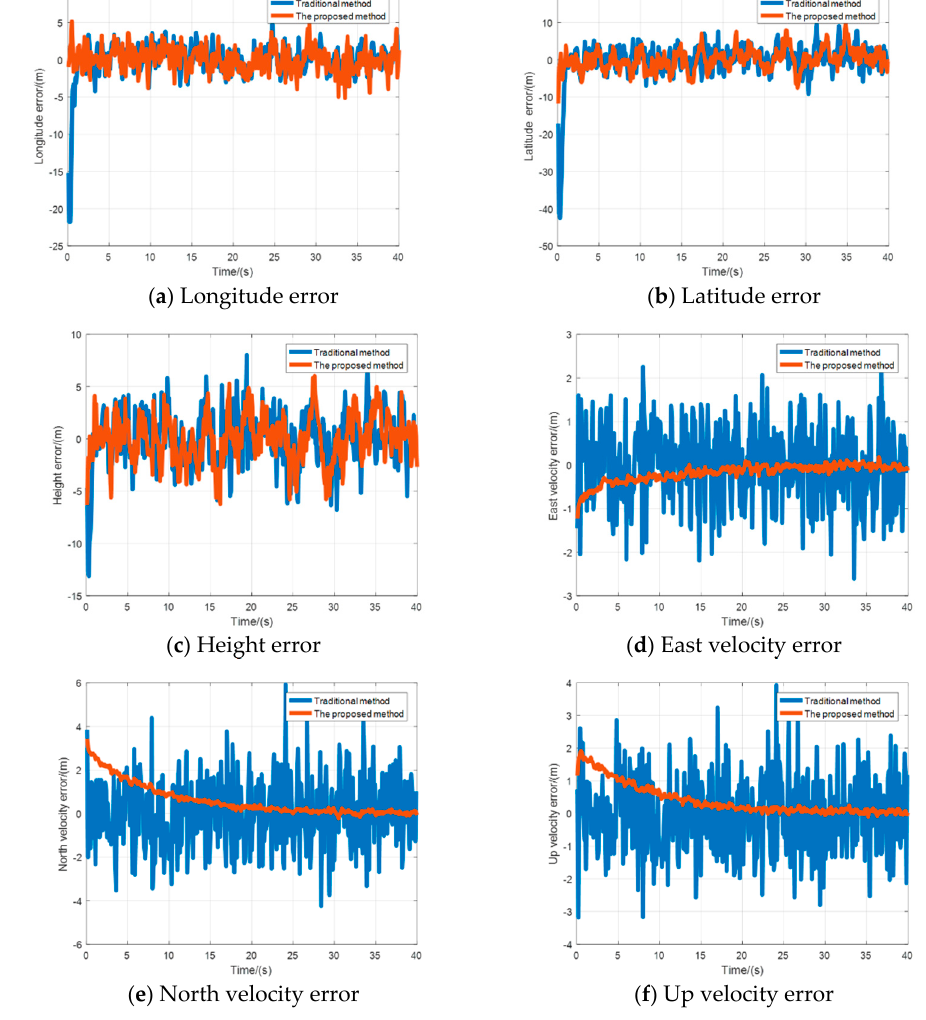
Figure 5. Comparison results of position error and velocity error in the static test.